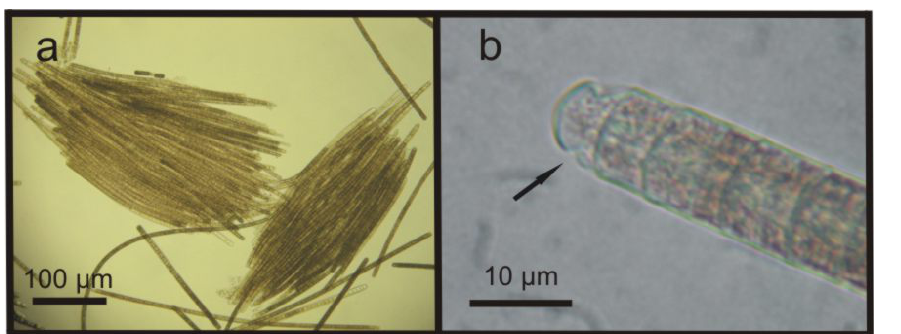
Figure 2. Trichodesmium erythraeum , from sample #2, showing ( a ) parallel trichomes and, in detail, ( b ) showing the caliptra (arrow).